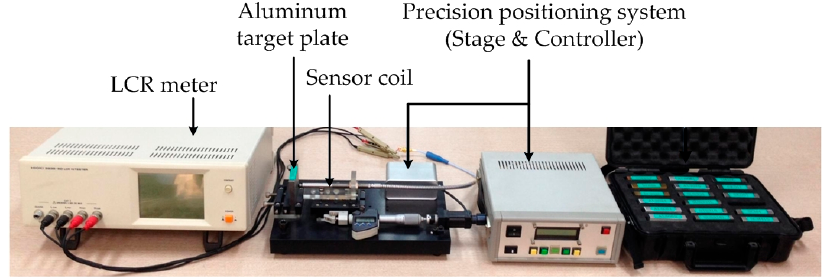
Figure 4. Coil impedance measurement system with gap controlled.